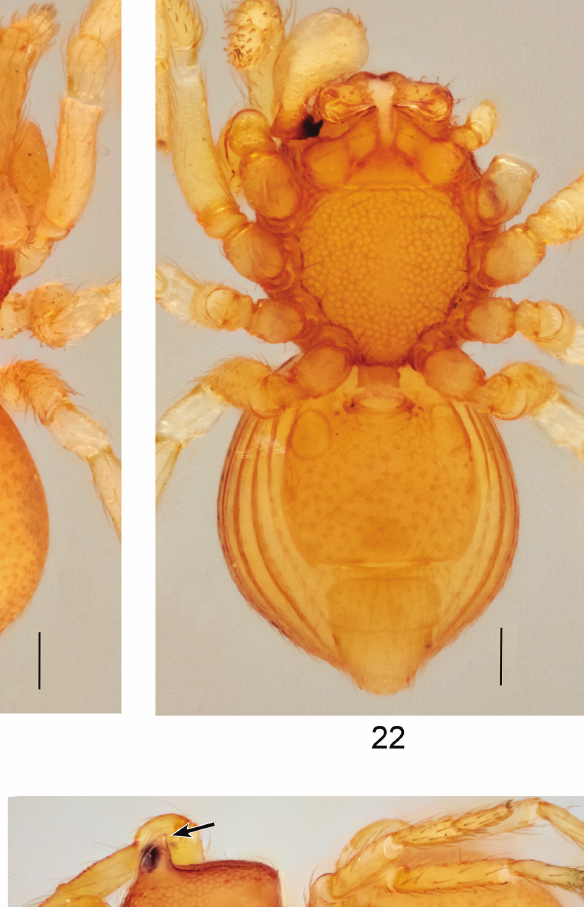
Figures 21–24. Ablemma kelinci sp. n., male. 21 Habitus, dorsal view. 22 Habitus, ventral view. 23 Carapace, frontal view. 24 Habitus, lateral view. Scale bar: 1.0 mm.